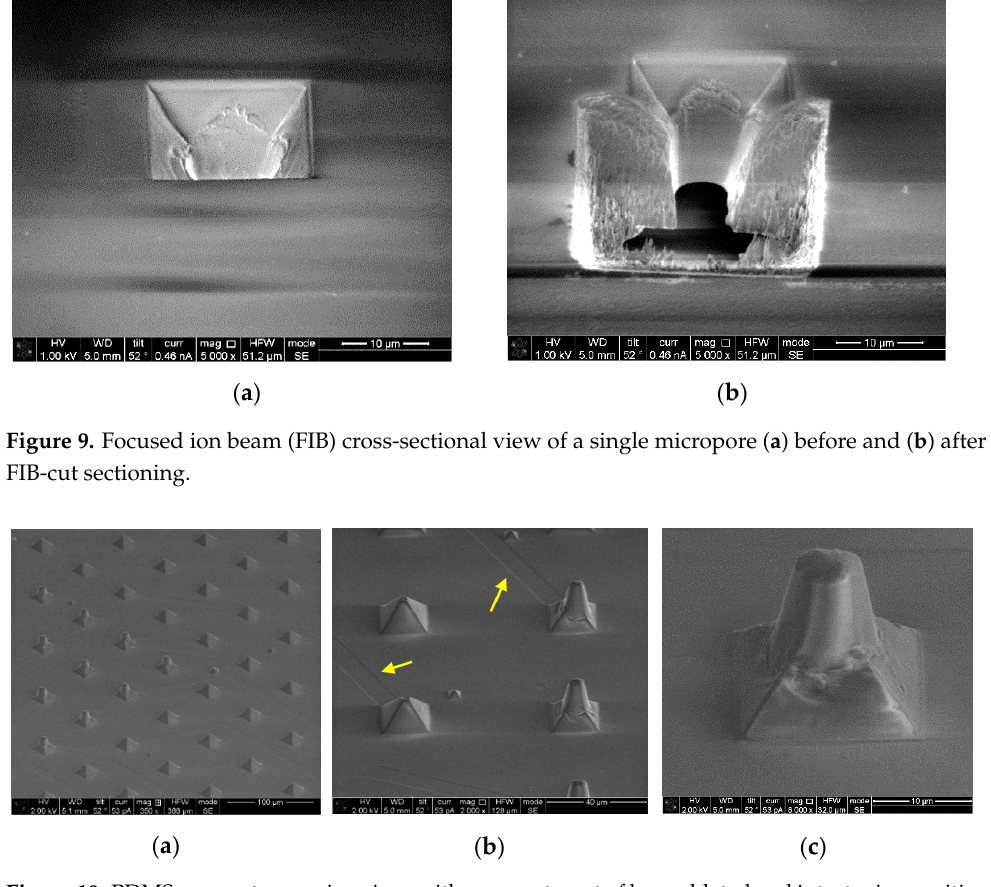
Figure 10. PDMS was cast on a microsieve with an assortment of laser ablated and intact microcav-